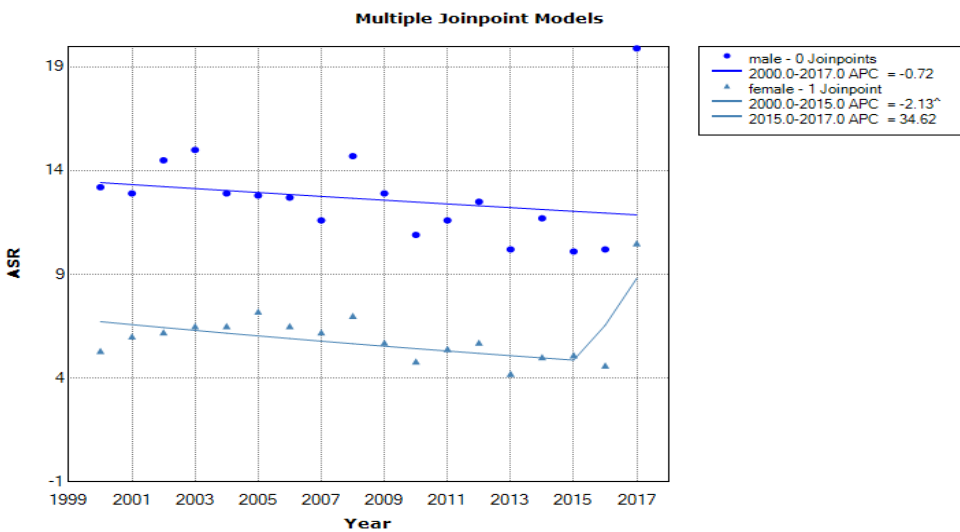
Figure 1. Incidence trend based on age-standardized incidence rates in stomach cancer in Central Serbia according to sex in the period from 2000 to 2017.